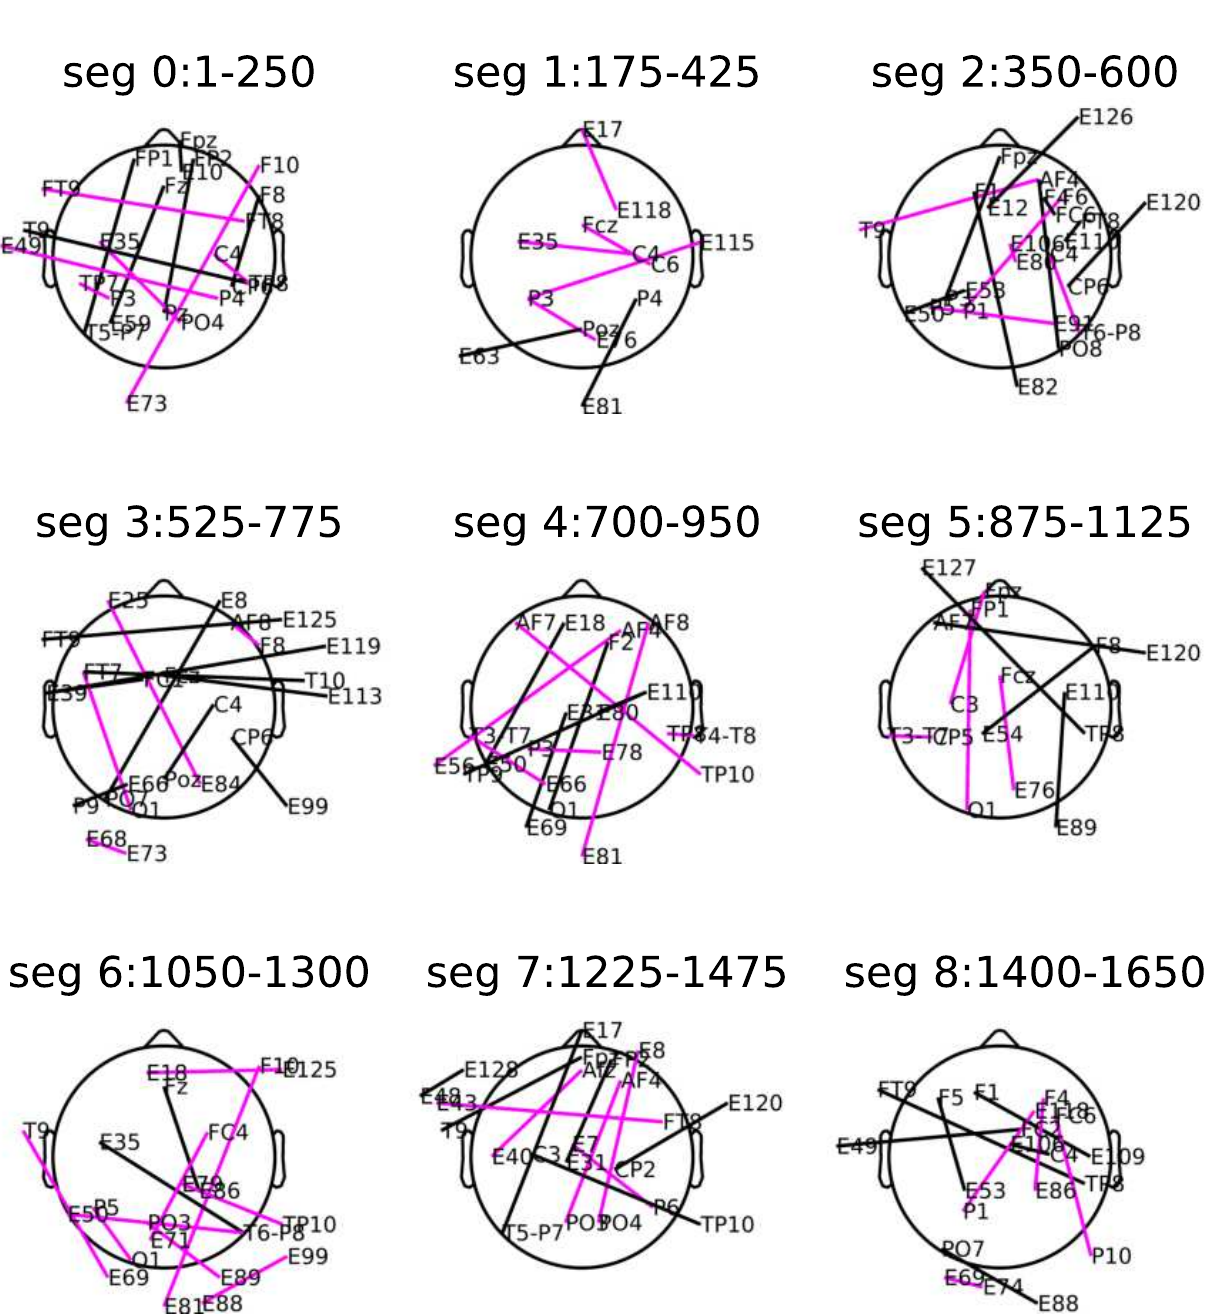
Figure 3. Significant functional connections in the upper beta band: Only significant connections are plotted. The color coding is as per the stats value as follows: magenta (5 < stats (cid:54) 6), black (6 > stats ). Above each plot the information about duration of the segment is provided. Functional connections for Group-03 is presented here. See Figure S1 for plots related to other